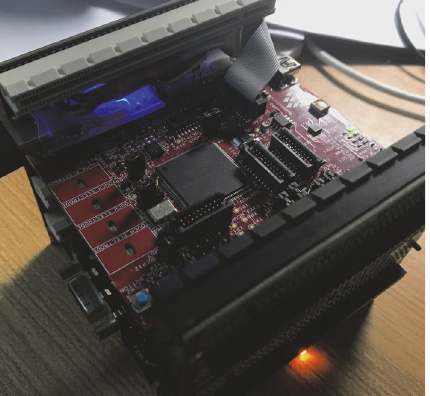
Figure4:Designedhardwarefordataacquisitionfromhandgesture sensor.